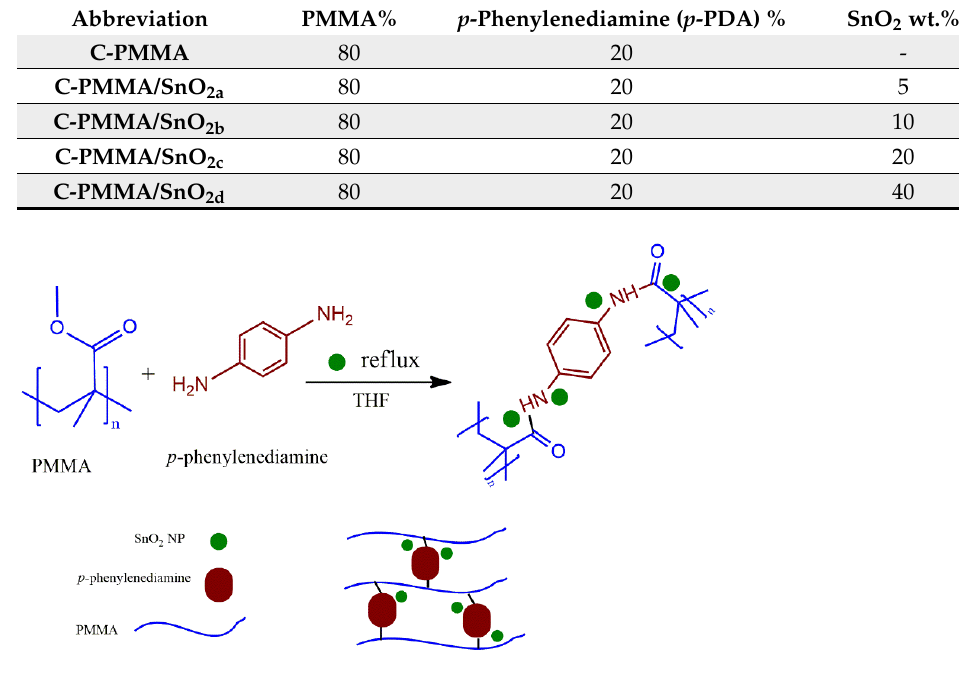
Figure 1. Representation diagram for synthesis of C-PMMA/SnO 2